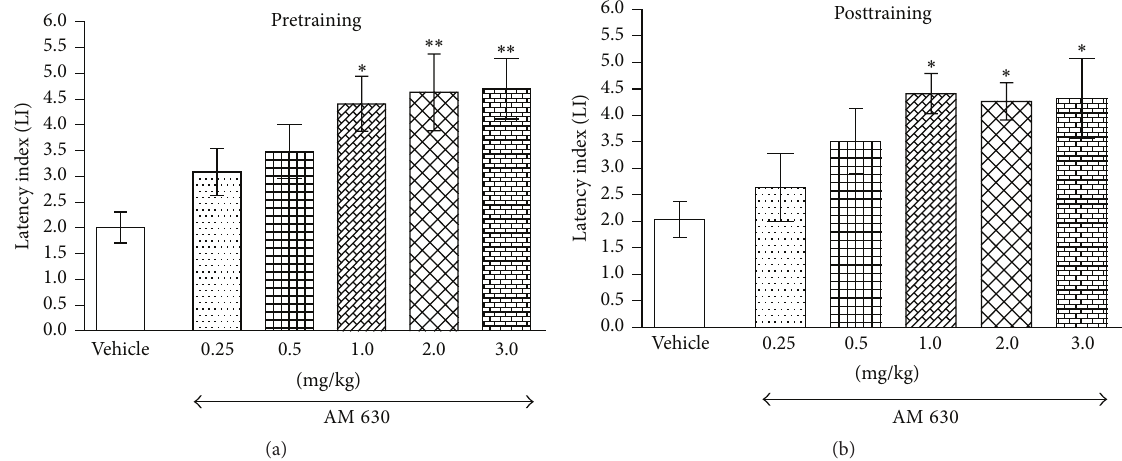
Figure4:Effectsofacutepretraining(a)orposttraining(b)CB2receptorantagonistAM630orsalineadministrationonthelatencyindex(LI) in the PA test in mice. AM 630 (0.25, 0.5, 1.0, 2.0, and 3.0 mg/kg; ip) or vehicle was administered 30min before the first trial (a) or immediately after the first trial (b) and the mice were retested 24 h later; 𝑛 = 8 – 12 ; the means ± SEM; ∗ 𝑝 < 0.05 ; ∗∗ 𝑝 < 0.01 versus vehicle-treated control group; Tukey’s